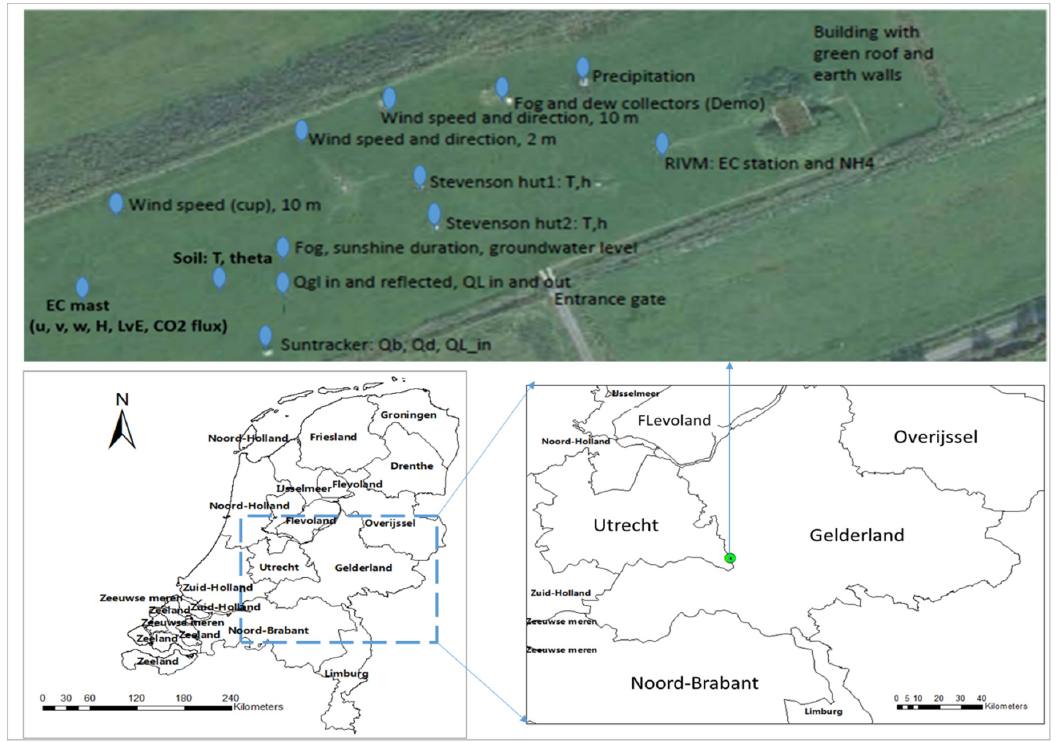
Figure 1. The Veenkampen Station equipped with the eddy covariance (EC) and automated weather station system, is located in Wageningen University at the center of Netherlands.